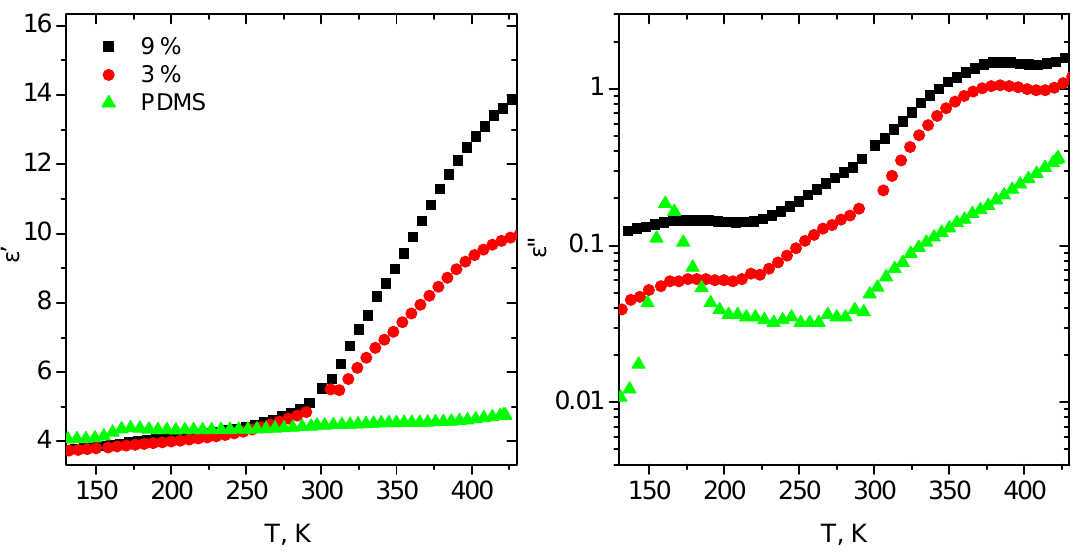
Figure 3. Temperature dependences of the dielectric permittivity of the composite materials at 24 kHz with different amount of